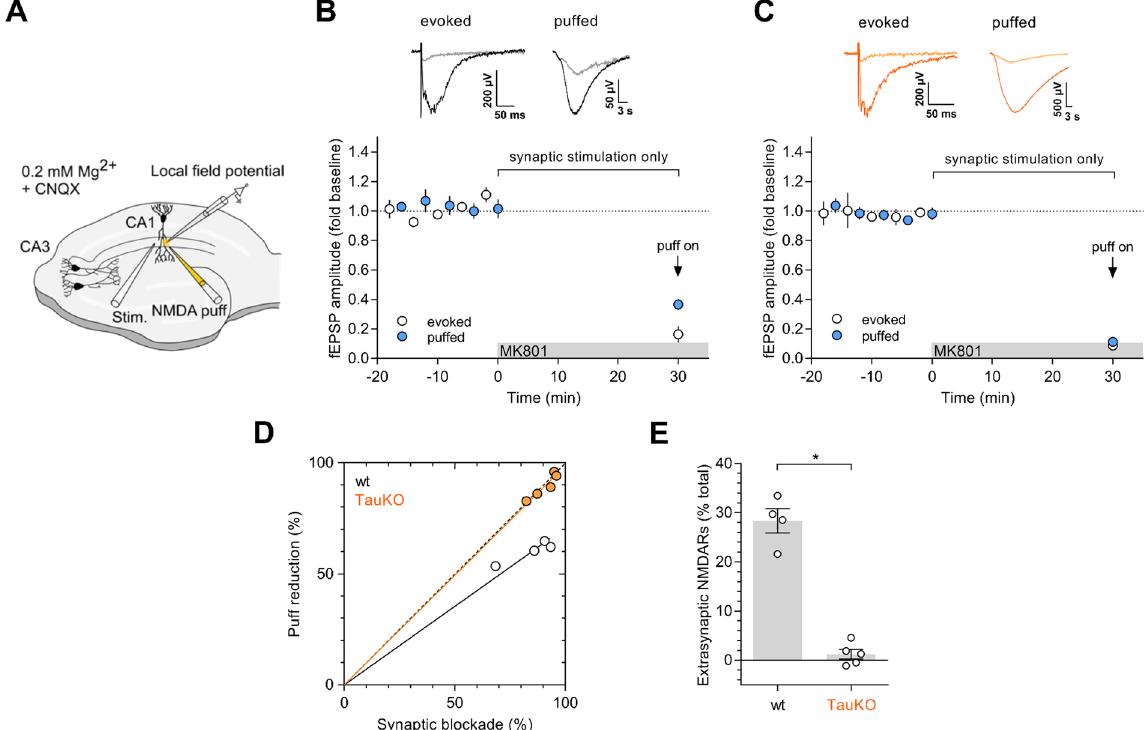
Figure 4. Electrophysiological detection of extrasynaptic NMDA receptors in the CA1 region of wild-type and Tau − / − mice. ( A ) Cartoon representation of the experimental configuration for local field potential recordings in the CA1 region of hippocampal slices using electrical stimulation of CA3 Schaffer collaterals (for synaptic responses) and a glass pipette to deliver local NMDA puffs (for synaptic plus extrasynaptic responses). Currents from NMDA receptors are isolated by blocking AMPA receptors with CNQX and in the presence of a low concentration of Mg 2 + . ( B , C ) Time course of NMDA receptor-mediated responses from WT (B) and Tau − / − ( C ) slices with alternating synaptic (white symbols) and puff (blue symbols) stimulation. MK801 is added to the perfusion solution at t = 0, as indicated (gray bar). At this point, puffed stimulation is stopped, and it is resumed only once inhibition of synaptic responses has stabilized (indicated with an arrow). ( D ) Scatter plot for the relative inhibition of electrical (synaptic) and puff (synaptic plus extrasynaptic) responses after MK801 incubation for slices from WT (white symbols) and Tau − / − (orange symbols) animals. Dotted diagonal line represents identical inhibition of both responses. Points below the diagonal indicate stronger inhibition of the synaptic response as compared to the puff response. ( E ) Calculation of the relative contribution of extrasynaptic receptors to the puff response from the data shown in (D), as described in (Papouin et al., Cell 2012 Aug